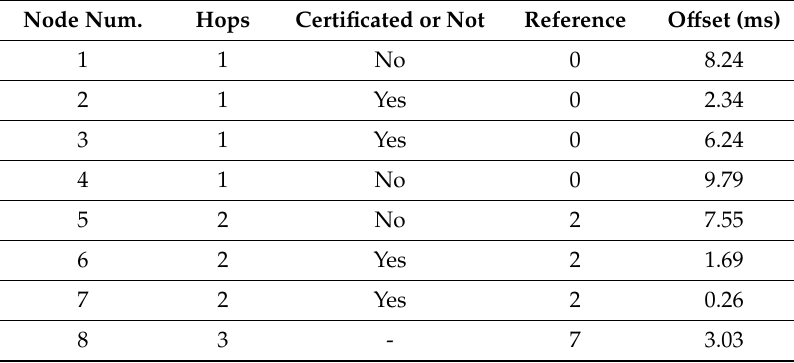
Table 3. Parameters of embedded Linux platforms after the test.